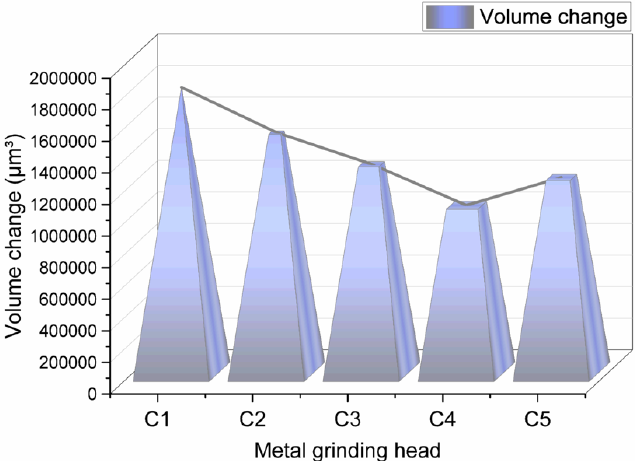
Figure 13. Change in the metal volume before and after friction.